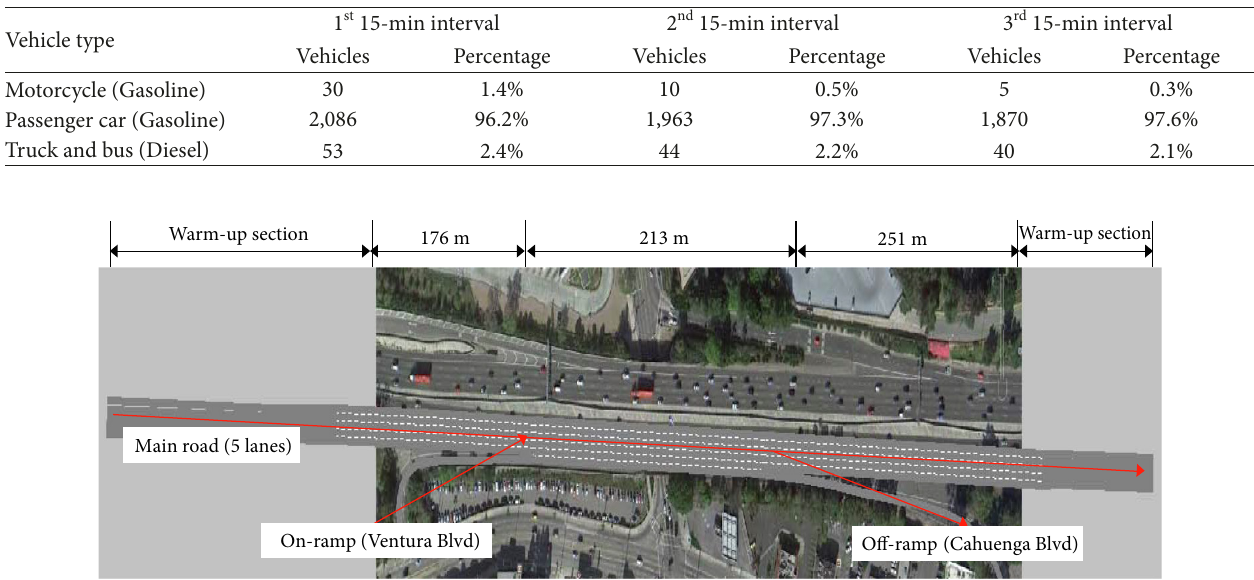
Figure 2: Schematic of test site (weaving section